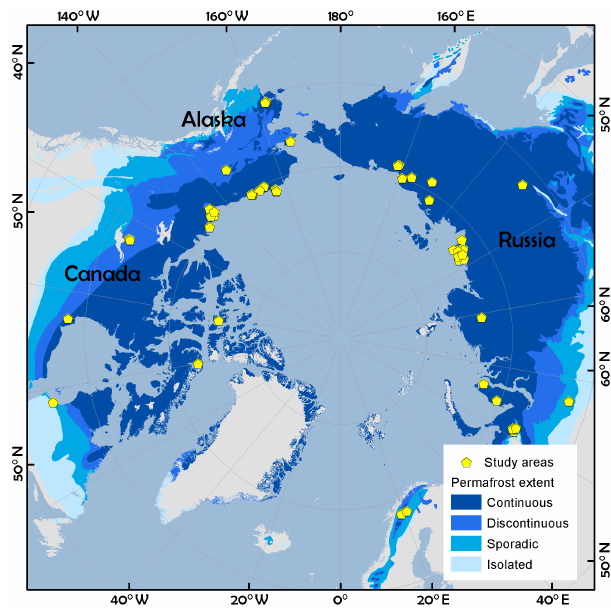
Figure 1. Distribution of PeRL study areas. Permafrost extent ac- cording to Brown et al.